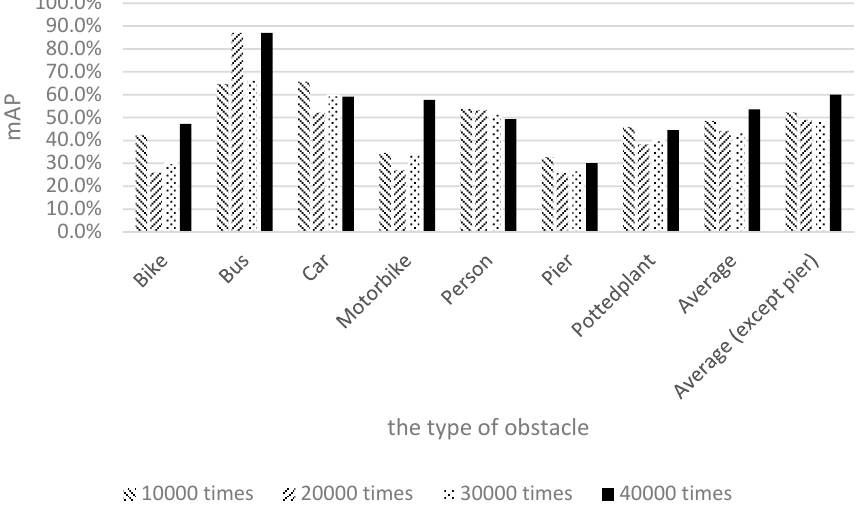
Figure 17. Results of using Pascal images and 1710 images captured by the researchers of this study.